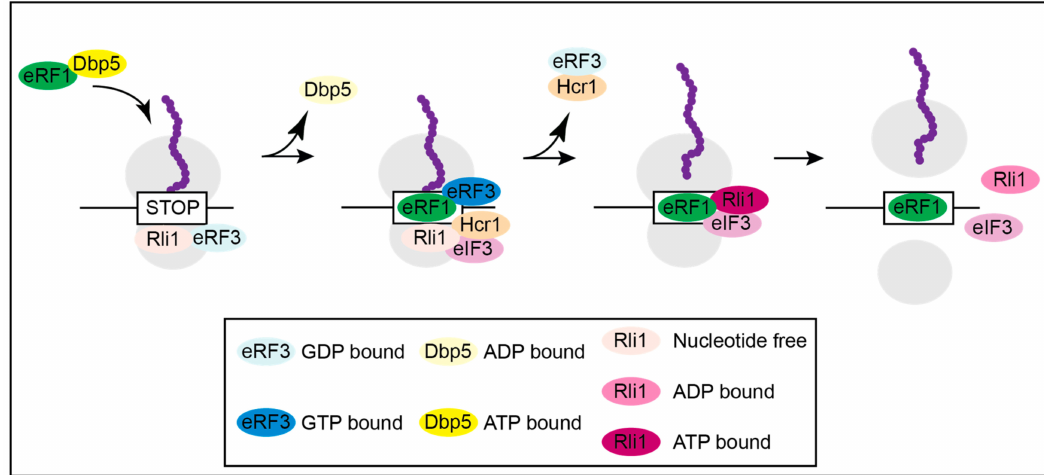
Figure 2. Model for translation termination. The yeast DEAD-box RNA helicase Dbp5 delivers eRF1 to the ribosome located on a stop codon. Its function is to prevent an early contact of eRF1 with eRF3. As soon as eRF1 was placed properly, the ATP-hydrolysis of Dbp5 dissociates the helicase. Free eRF1 subsequently contacts eRF3 that waited in its GDP-bound form attached to Rli1. This contact triggers GTP-binding of eRF3 and subsequent hydrolysis causing polypeptide chain and tRNA release. At the same time, eIF3 delivers Hcr1, which eliminates eRF3 from the complex. Removal of eRF3 enables contact of eRF1 with Rli1-ATP and through ATP-hydrolysis the ribosomal subunits are